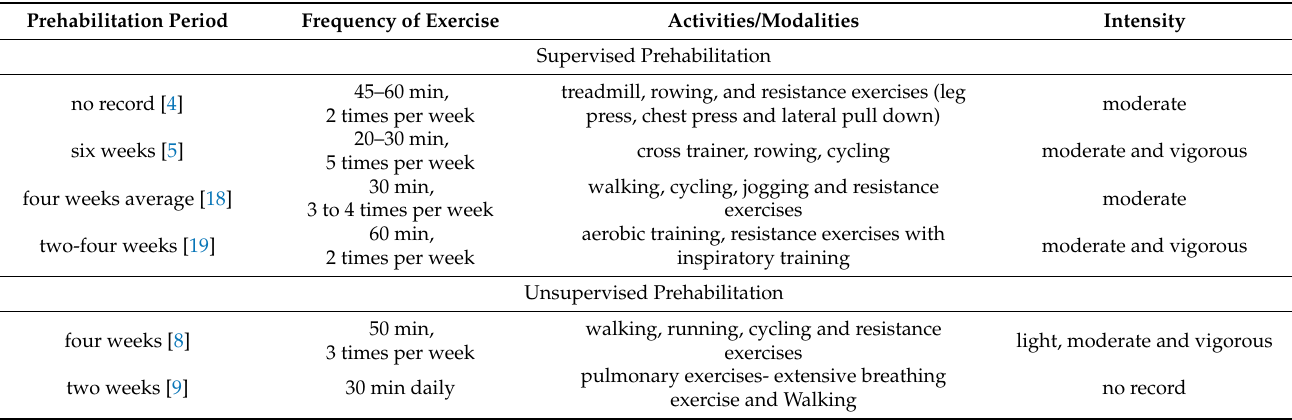
Table 1. Examples of exercise parameters used in supervised and unsupervised prehabilitation programs for cancer patients undergoing abdominal